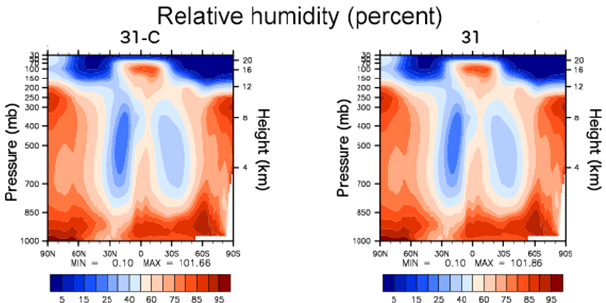
Figure 19. Vertical contour plot of DJF (December–January– February) zonal means for relative humidity (RELHUM) from 2006 to 2099 for ensemble member 31. The data in the left subplot have undergone lossy compression (i.e., 31-C) and the right subplot con- tains the original